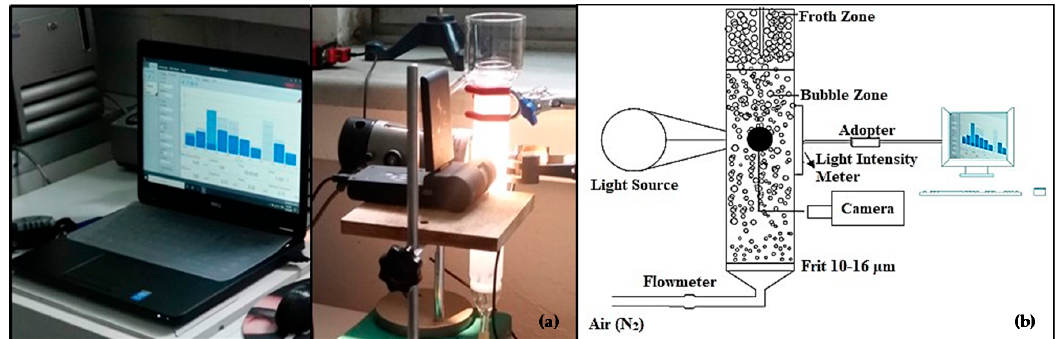
Figure 1. ( a ) Experimental set-up of bubble coalescence measurement, ( b ) Schematic representation of bubble coalescence